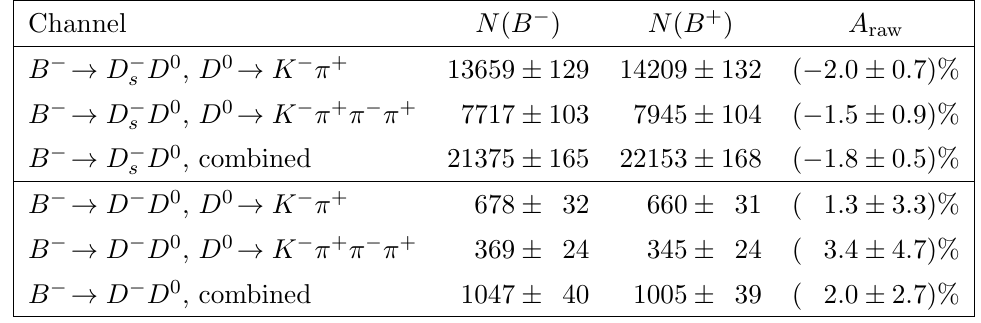
Table 1 . Yields and raw asymmetries for B (cid:0) ! D (cid:0)